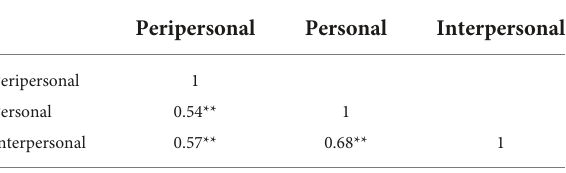
TABLE 1 Pearson correlation matrix for the average size of peripersonal space (PPS), personal space (PS) and interpersonal space (IPS).